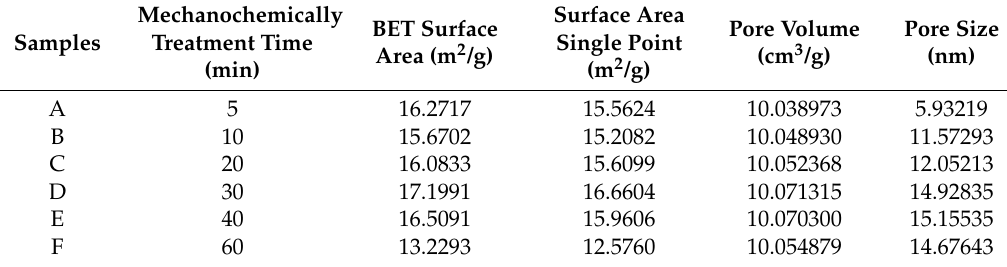
Table 2. The surface area, pore volume and pore size of the activated clay